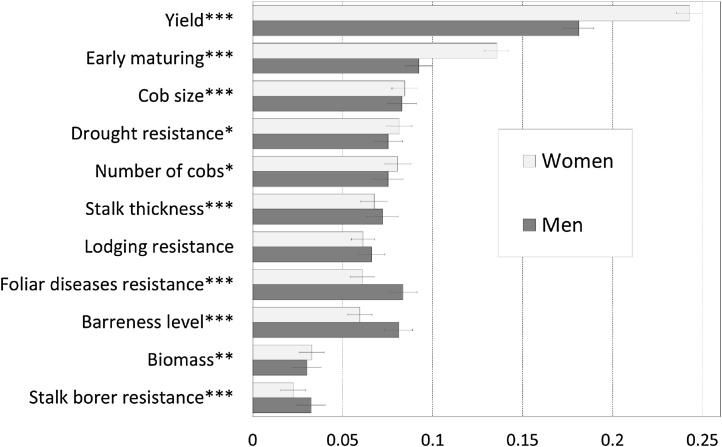
Revealed criteria contribution to overall evaluation by gender (asterix indicate significant differences between men and women, error bars are standard errors of the regression coefficients).